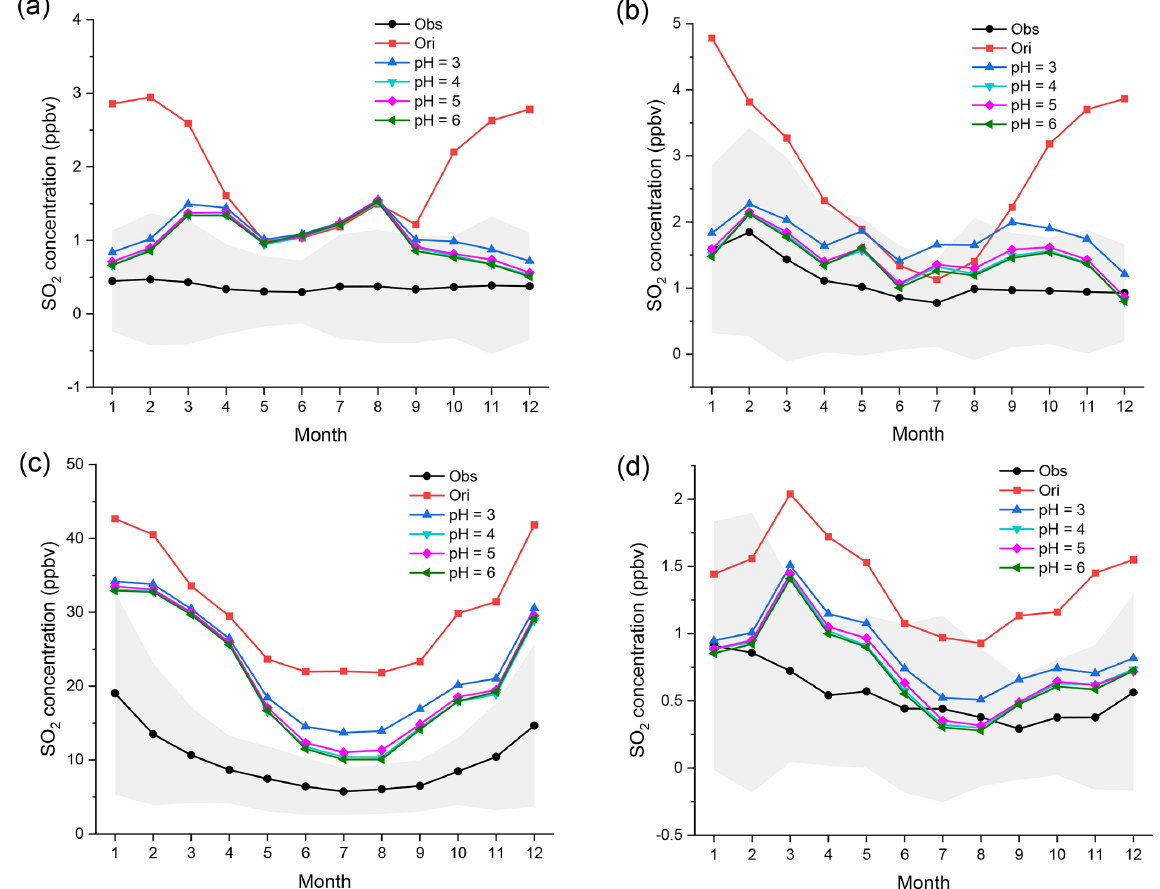
Figure 7. Regional monthly average mixing ratios (ppbv) of SO 2 in EU, USA, CN, and JK in 2015. The black and red lines represent the observed and original-simulated mixing ratios of SO 2 , respectively. Other lines represent SO 2 mixing ratios at different pH values. The pH values, from top to bottom, are 3, 4, 5, and 6, respectively. [Fe 3 + ] is set to 5µM. The gray areas represent the standard deviation of observed mixing ratios. The corresponding monitoring networks are (a) EMEP, (b) EPA, (c) CNEMC, and (d)